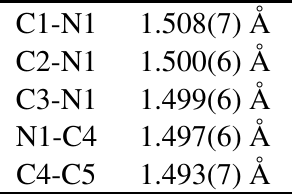
Table 3. Distances in the betainium cation in (Hbet)